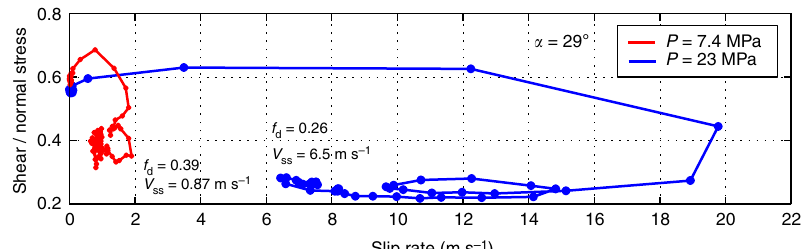
Figure 6 | Evolution of dynamic friction with slip rate. Friction evolution is presented for the experiments at two far-field loads, P ¼ 7.4MPa (red) and P ¼ 23MPa (blue) and angle a ¼ 29 (cid:2) . These curves correspond to the two ruptures shown in Figs 4a,b and 5a,c. Both cases show initial strengthening with slip rate (direct effect) followed by rate weakening, as captured by rate-and-state formulations. Note that the steady-state level of dynamic friction depends on the slip rate ( f d ¼ 0.39 for V ss ¼ 0.87ms (cid:2) 1 and f d ¼ 0.26 for V ss ¼ 6.5ms (cid:2) 1